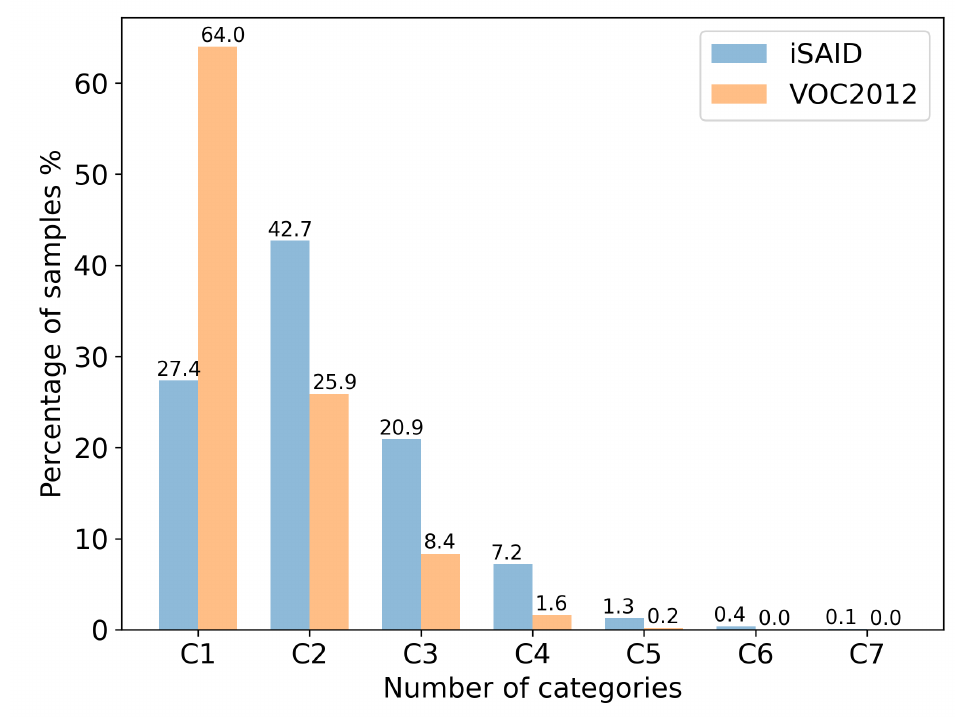
Figure 5. The proportion of images with various scene categories in the RS and NS datasets, which represents the number of images with various scene categories in relation to all images in the